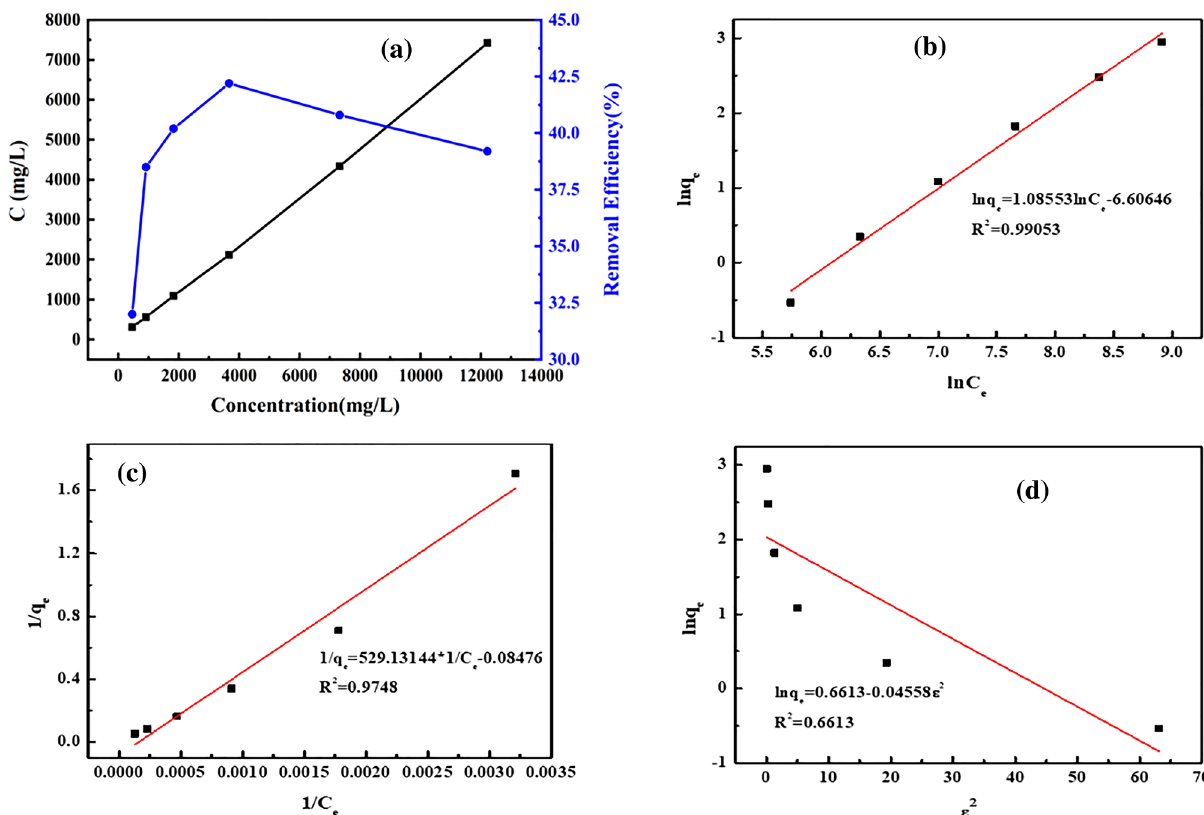
Figure 6. Variation curve of adsorption capacity and removal rate with concentration ( a ); Freundlich ( b ); Langmuir ( c ), and Dubinin–Radushkevich isothermal regression curve ( d